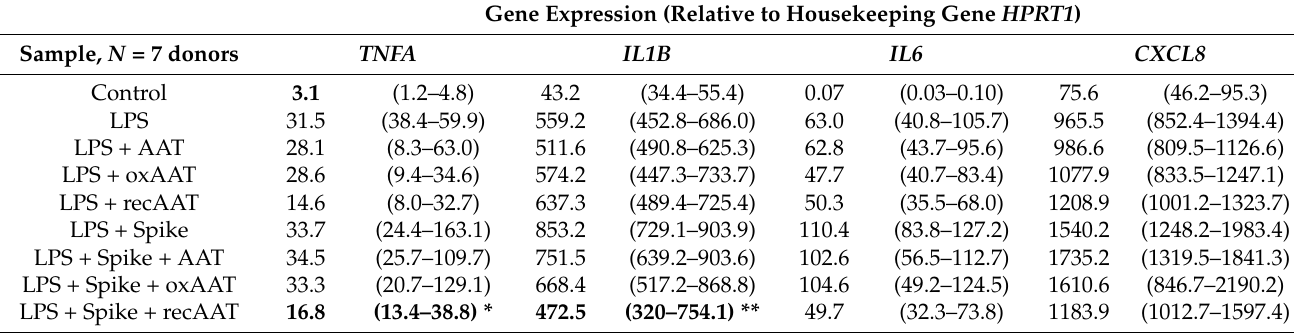
Table 1. Gene expression in PBMCs at 6 h